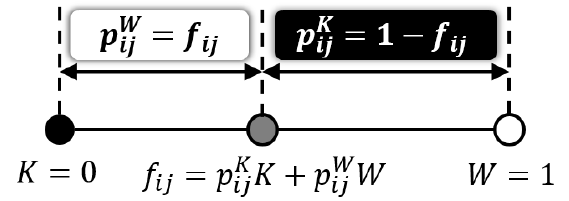
Figure 2. Grayscale Neugebauer